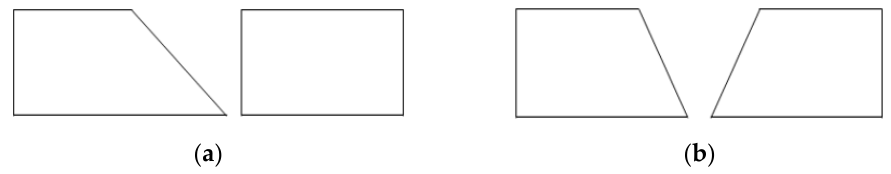
Figure 1. Typical weld joint configurations for arc welding: ( a ) single bevel; ( b ) single vee. As the size of ships and offshore structures has increased, the thickness of the steel used in the construction has consequently increased. As the use of heavy thickness plates increases, welding productivity for the heavy thickness plate became one of the most important factors in the overall work processes. To respond to this, the tandem SA welding process has been improved and applied to the panel stage for welding of plate to plate at the beginning phase of all construction operations.